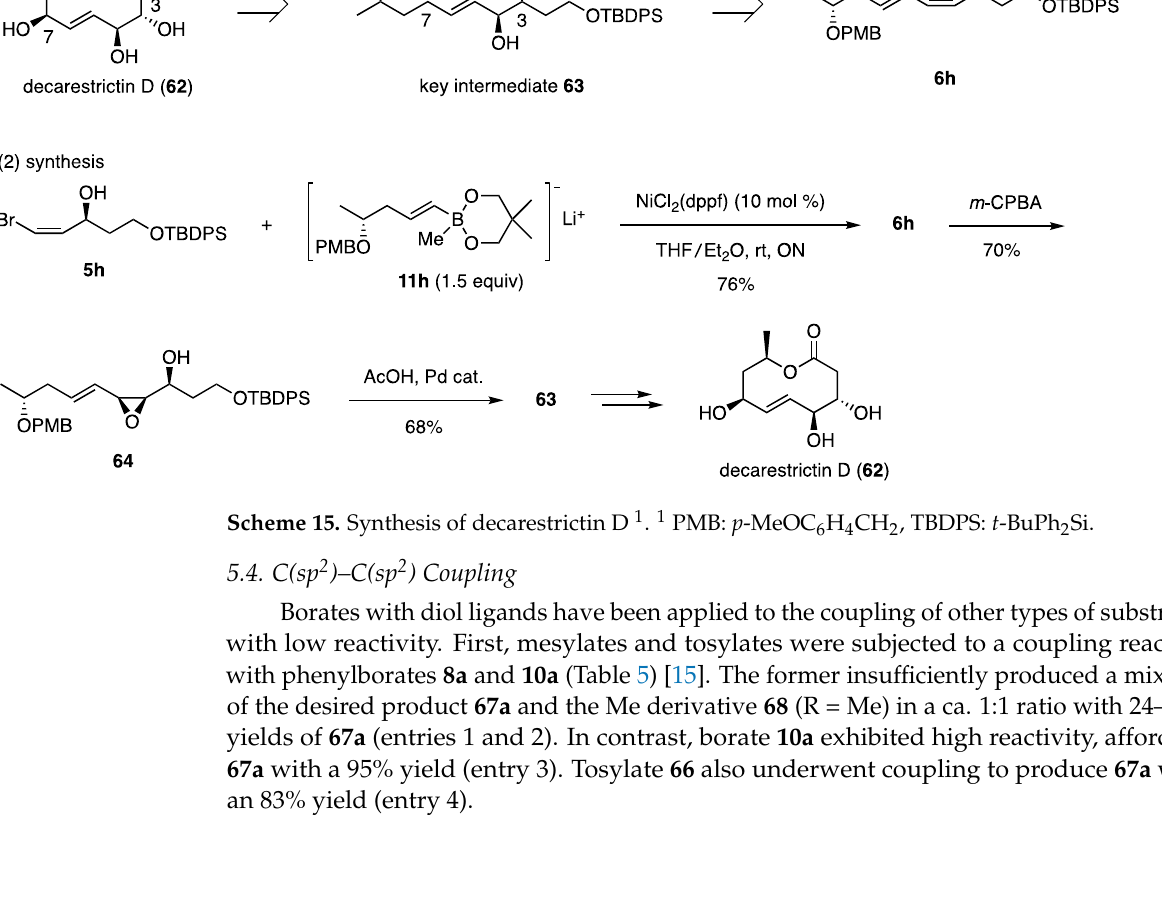
Table 5. Coupling reactions of